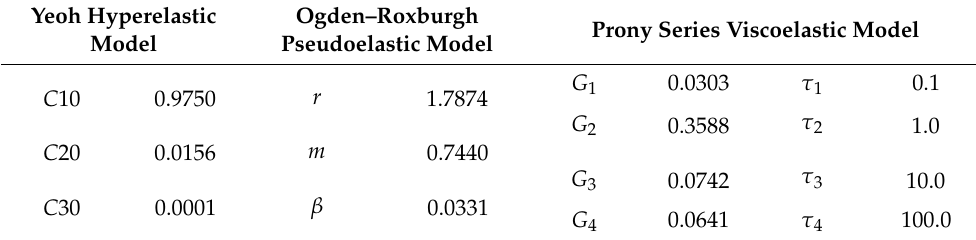
Figure 9. ( a ) The relationship between the reaction force and time when the sum of squared difference reaches a minimum value in the parameter identification process, and ( b ) comparison between the adjusted stress–strain data and the fitting results using the final optimized material parameters of the hyper-pseudo-viscoelastic constitutive model. Table 2. The optimized material parameters in hyper-pseudo-viscoelastic model for the carcass rubber and belt